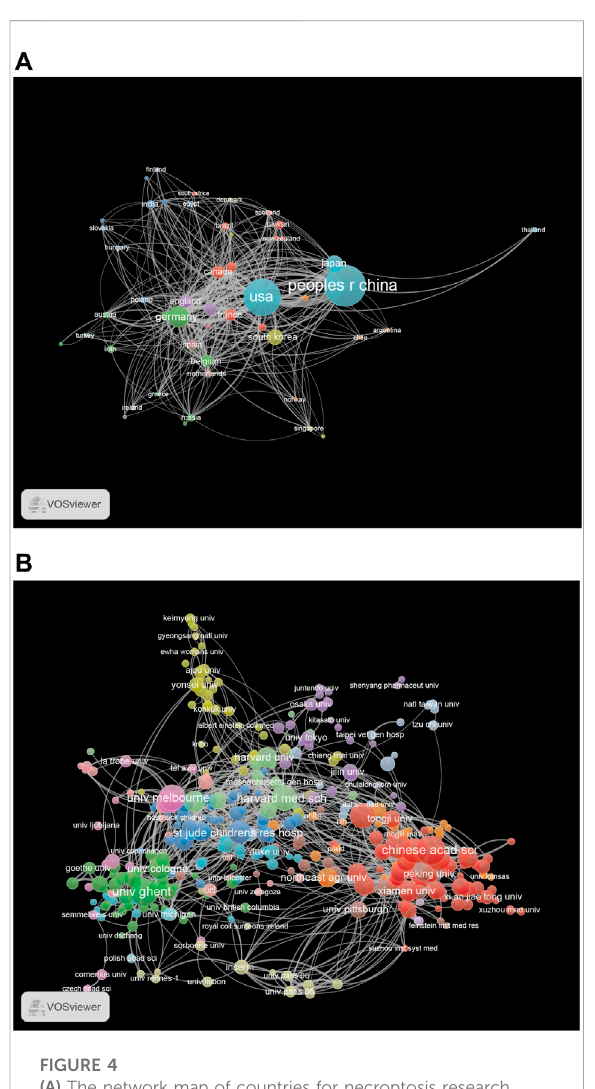
FIGURE 4 (A) The network map of countries for necroptosis research. (B) The network map of institutions for necroptosis